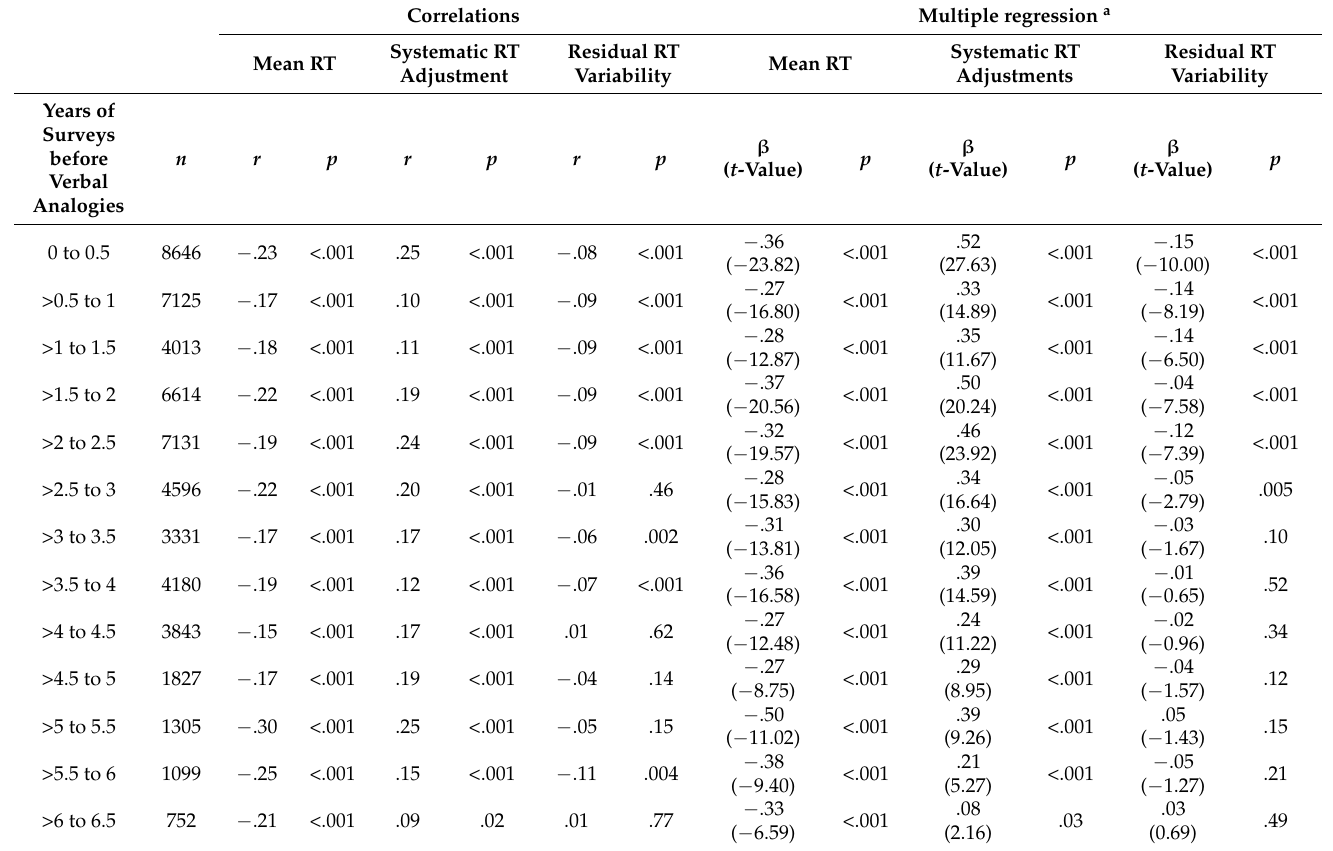
Table 7. Results for response time components as predictors of verbal analogies scores by time lag between surveys and cognitive assessment.